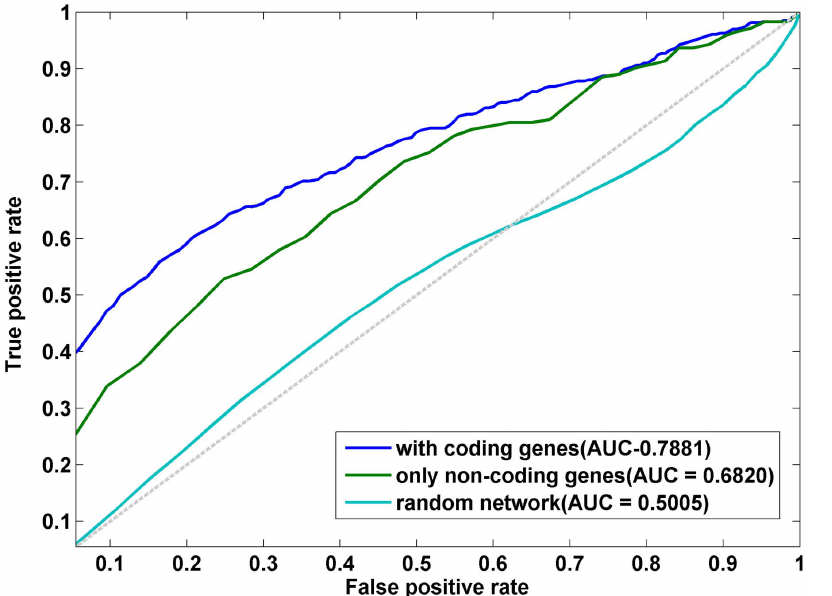
Figure 5. A comparison between the performance of our propagation algorithm on coding-non-coding gene-disease bipartite network and that on lncRNA-disease association network. The blue line represents the ROC curve of taking LOOCV over coding-non-coding gene-disease bipartite network, and an AUC of 0.7881 was obtained. The cyan line represents the ROC curve of taking LOOCV over lncRNA-disease association network, and an AUC of 0.6820 was obtained. The light blue line represents the ROC curve of taking LOOCV over random networks, and an average AUC of 0.5005 was obtained.